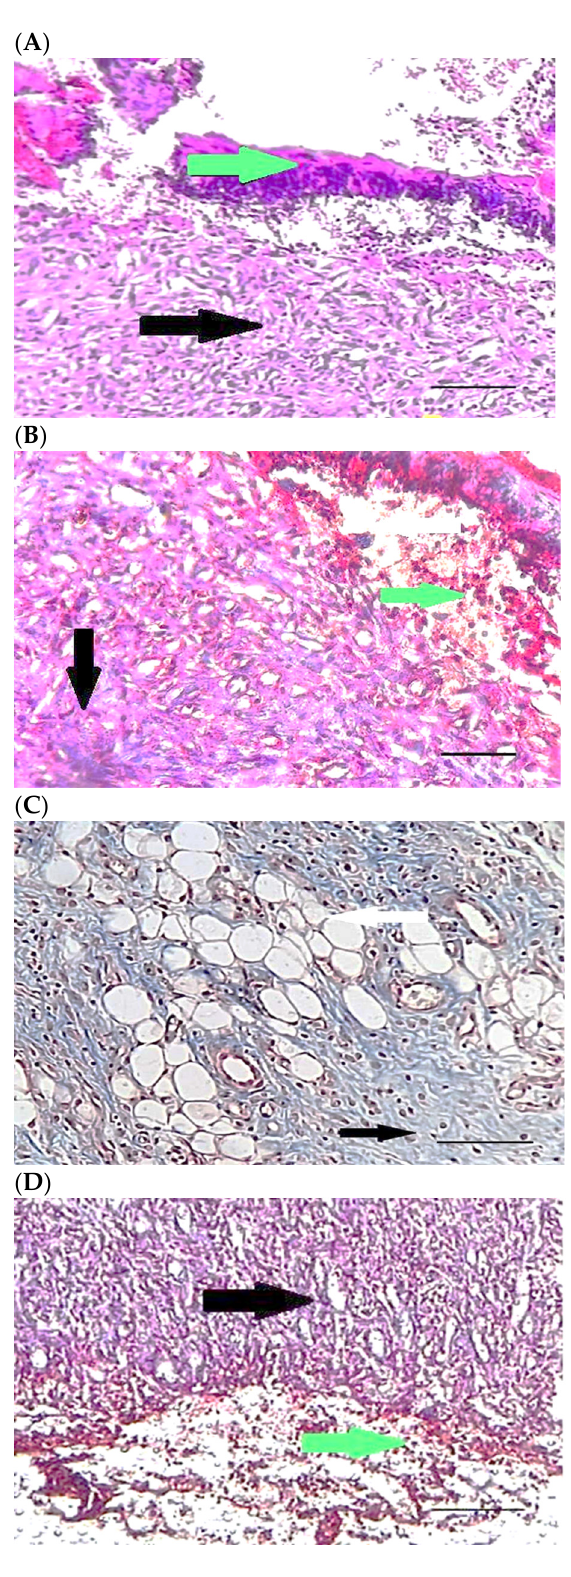
Figure 7. Mason trichrome stained microscopic sections (Bar = 50μm) wound in rats on day 3 of the study. ( A ) Control group; Clot and hemorrhage (green arrow), fine collagen fiber (black arrow). ( B ) Ch group; Clot (green arrow), fine collagen fiber (black arrow), edema (white arrow). ( C ) ChSeN group; Fine collagen fiber (black arrow), edema (white arrow). ( D ) ChSeND group; Clot and hemorrhage (green arrow), fine collagen fiber (black arrow).